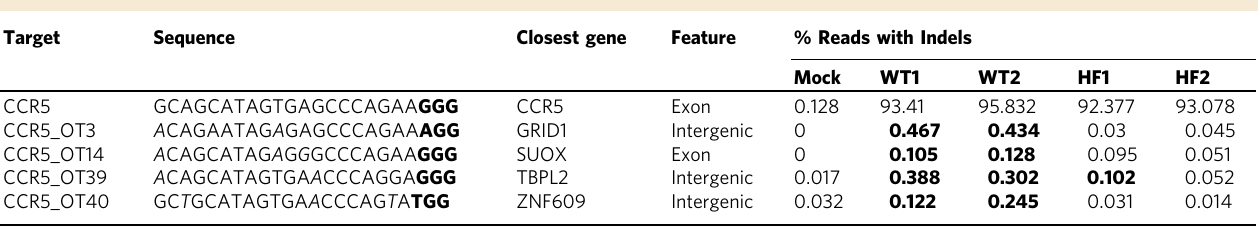
Fig. 6 OFF-target analysis of the CCR5 sgRNA. Percent reads with Indels at 62 off-target sites (OT) predicted using COSMID. For each site, red dots indicate samples treated with WT Cas9 and blue dots indicate samples treated with HiFi Cas9. The limit of detection for NGS is 0.1% and is indicated on the graph by a dashed line Table 1 Summary of off-target sites (OT ’ s) above level of detection